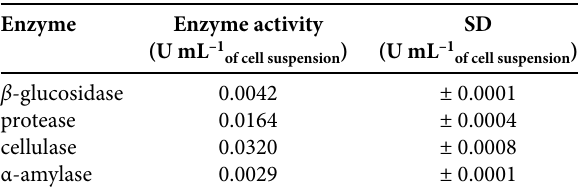
Table 4 : Initial activity of various enzymes in the H. werneckii cell suspension before homogenization and standard deviation of meas- urements (SD).